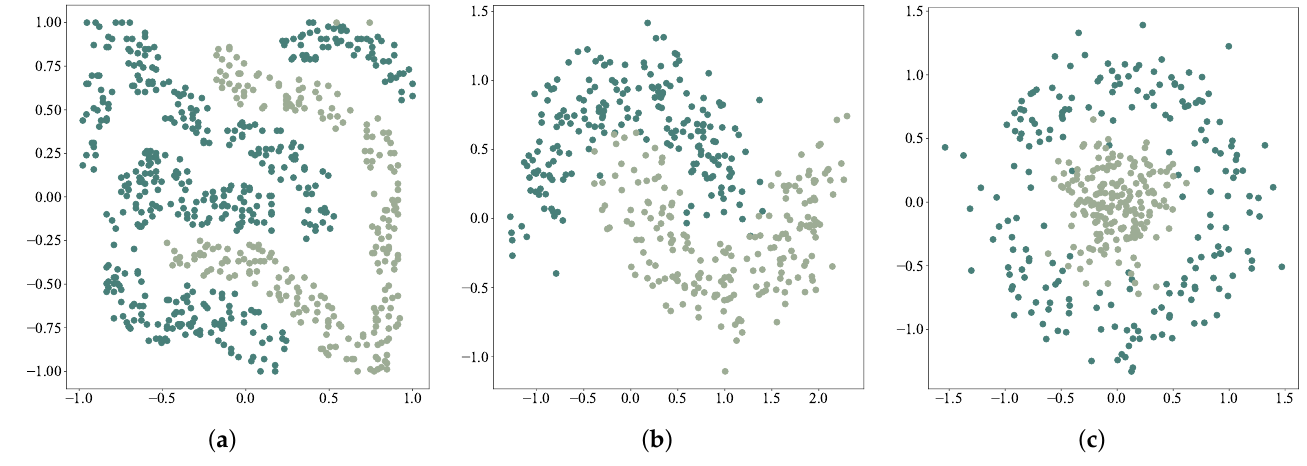
Figure 4. Clean distributions of two-dimensional data sets. ( a ) fourclass. ( b ) moons. ( c ) circles. Figure 4 contains three subfigures, and each subfigure corresponds to one data